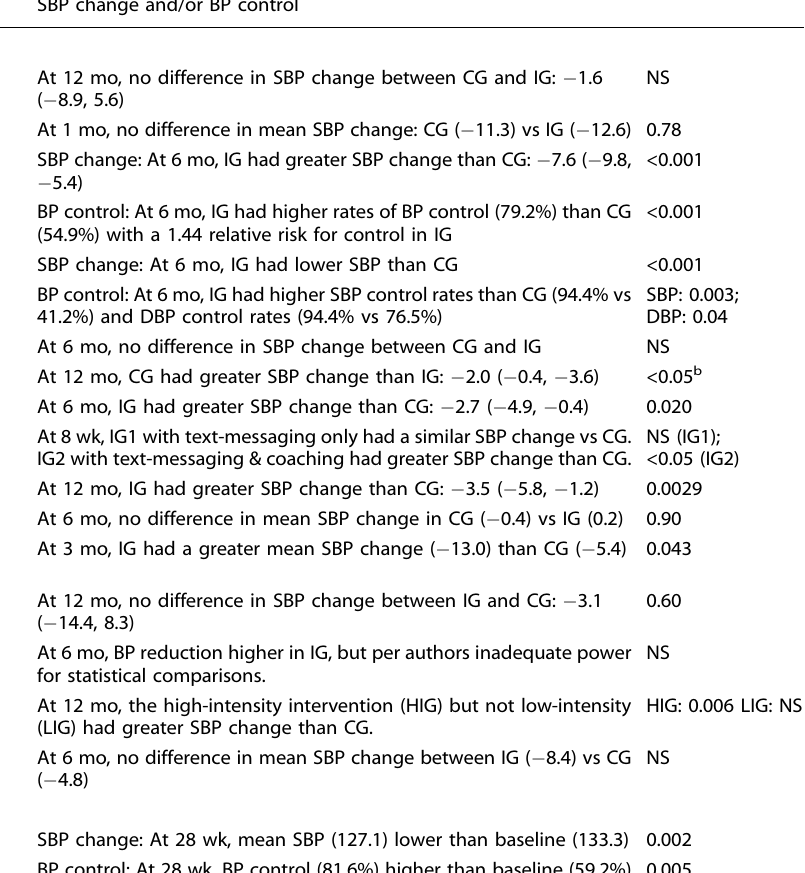
SBP change and/or BP control